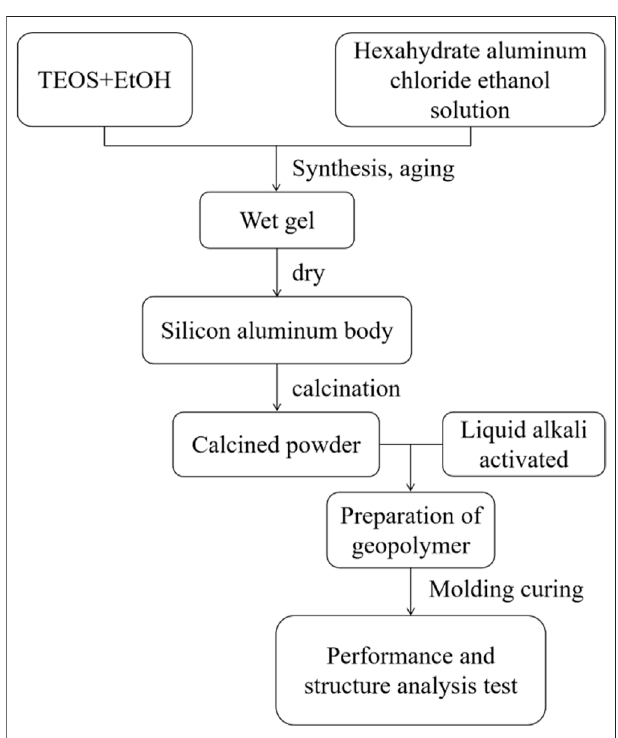
FIGURE 1 | Process fl ow chart of preparation of mineral polymer precursor by sol-gel